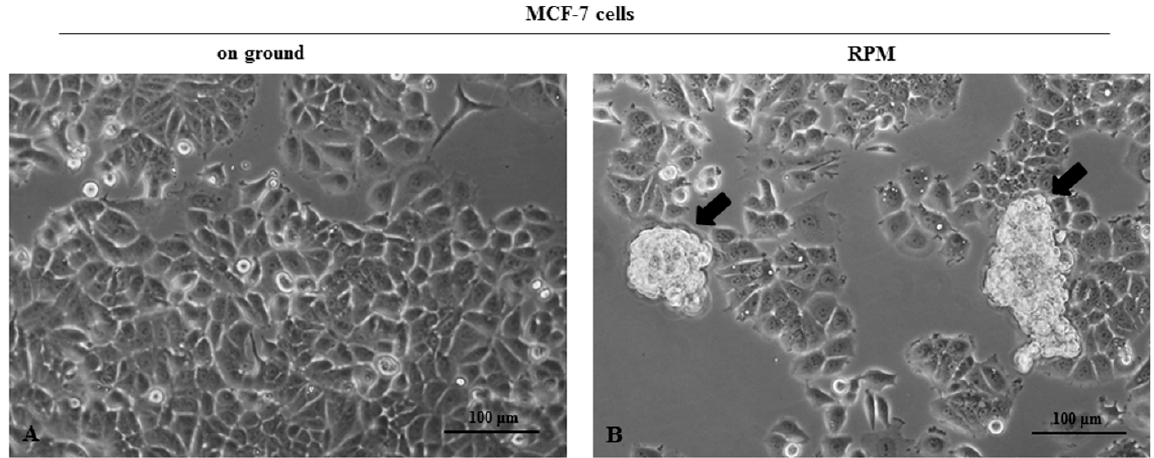
Figure 2. Microphotographs of MCF-7 by optical microscopy. MCF-7 cell line in the on-ground control condition ( A ) and exposed to microgravity ( B ) for 24 h. MCF7 cells in microgravity were distributed into two populations. The first, repre- sented by floating-clump (random positioning machine (RPM)-CLUMP) cells, are indicated by black arrows, and the sec- ond are composed adherent cells (RPM-AD.) Magnification ×100. Scale bar 100 µm.